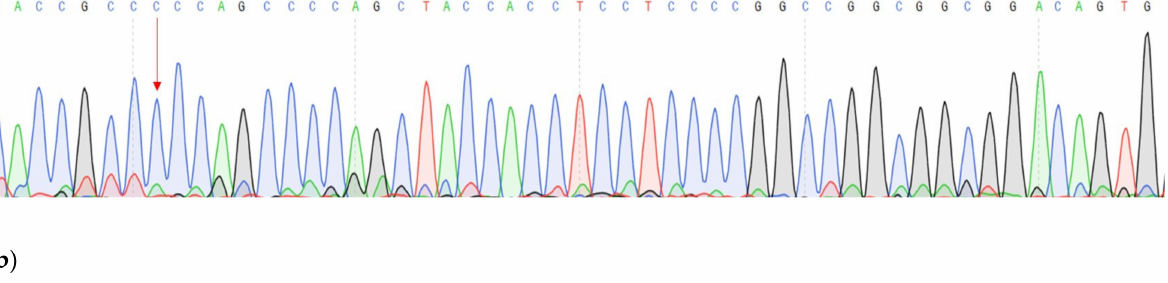
Figure 4. Fragments of the DNA sequence with the c.27_28insCCCAGCCCCAGCTACCA variant in the VEGFA gene. ( a ) DNA sample with a change isolated from the tumor tissue of a 1 GC patient; ( b ) Control DNA sample without change.